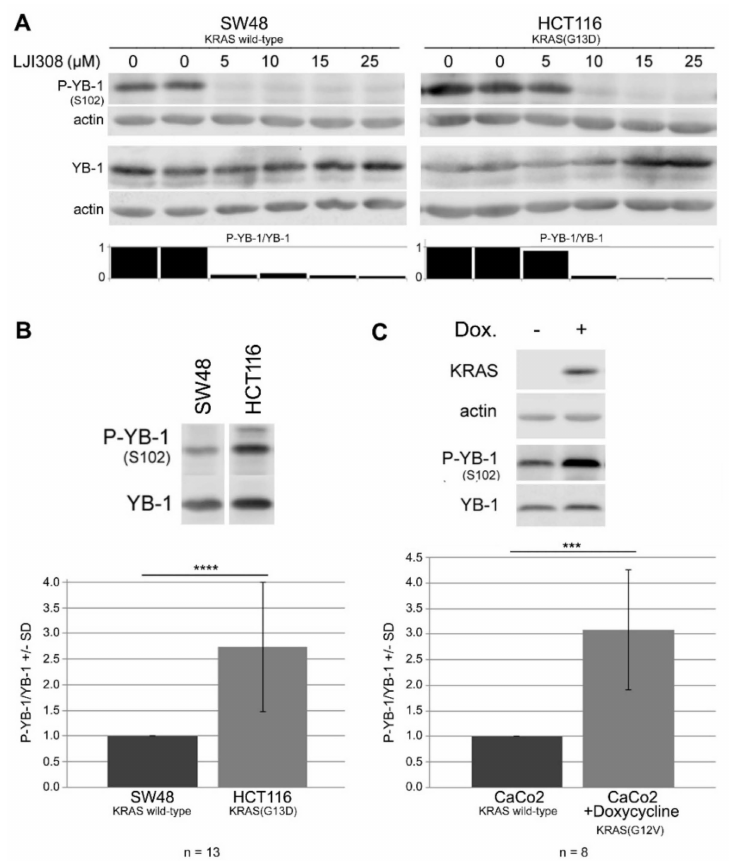
Figure 3. Targeting p90 ribosomal S6 kinase (RSK) by LJI308 inhibits phosphorylation of YB-1 at S102 in CRC cells. ( A ) KRAS wild-type SW48 and KRAS(G13D)-mutated HCT116 cells were treated